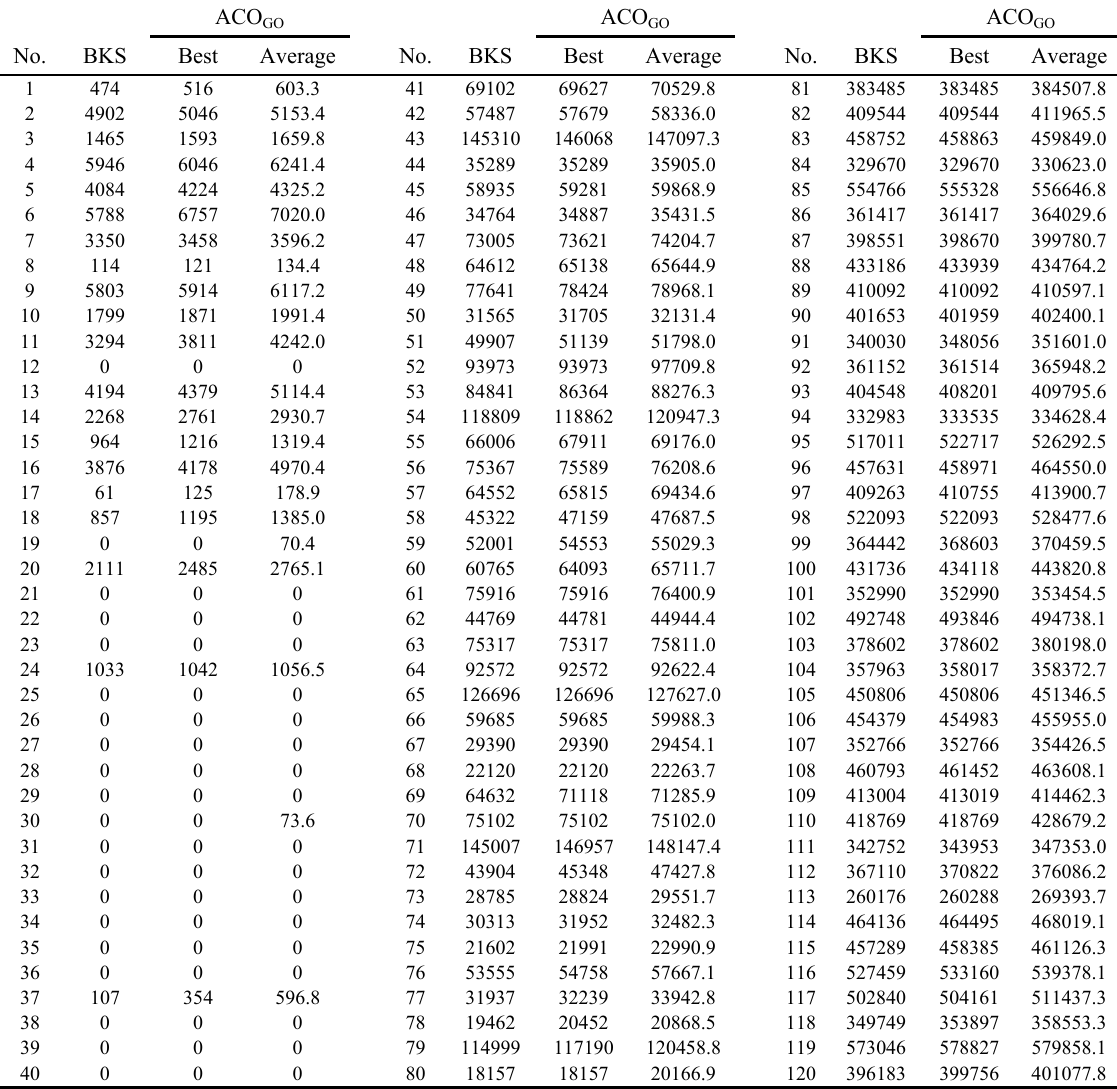
Table 1. Performance of the proposed ACO algorithm on the benchmark